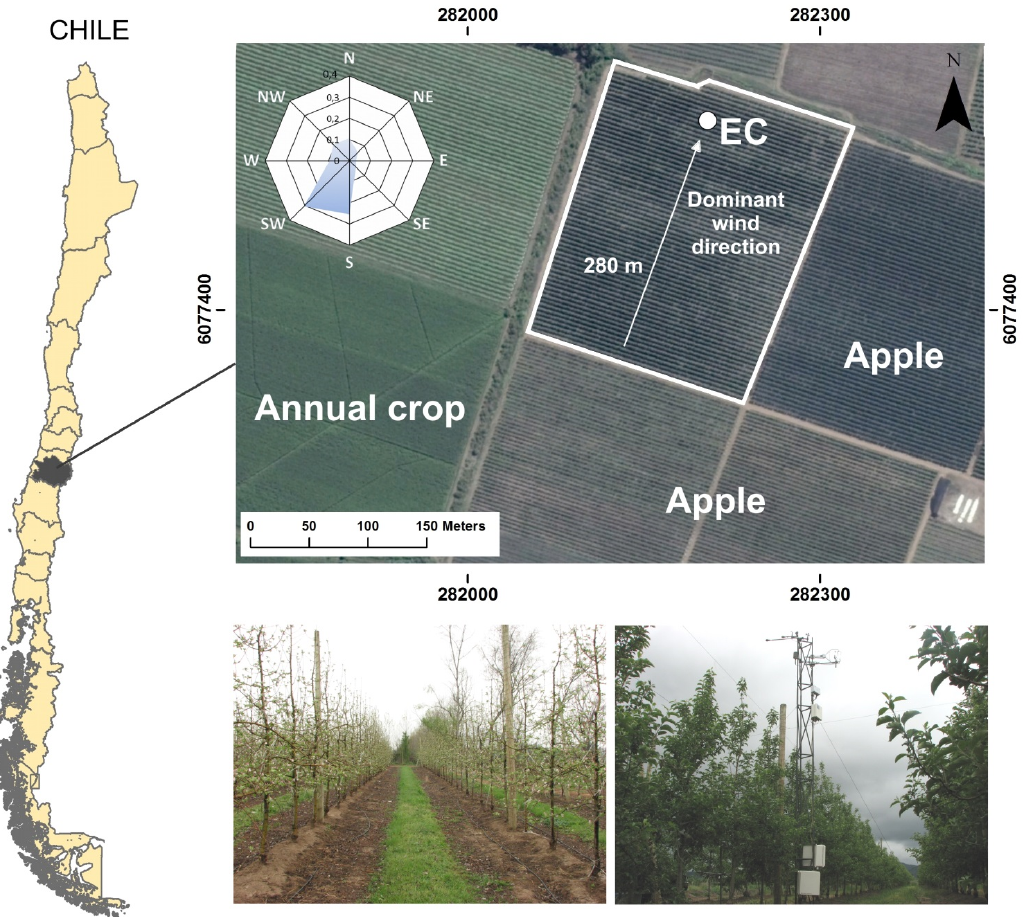
Figure 1. Location of the experimental apple orchard, the eddy covariance flux station and the surrounding fields.